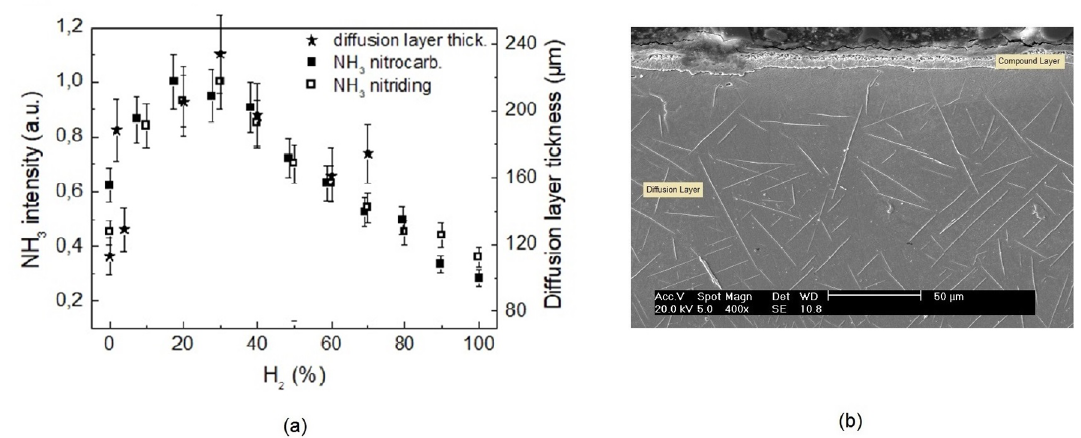
Figure 11. Correlation between the ammonia formation and the diffusion layer thickness obtained during nitriding and nitrocarburizing